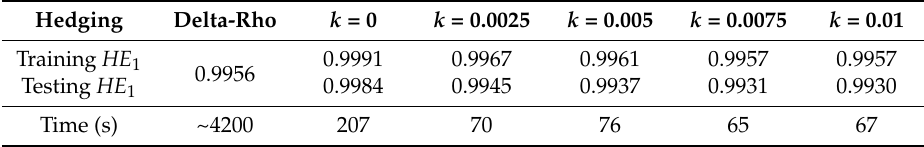
Table 4. Hedging metrics for different hedging strategies and error functions for guaranteed minimum accumulation benefit